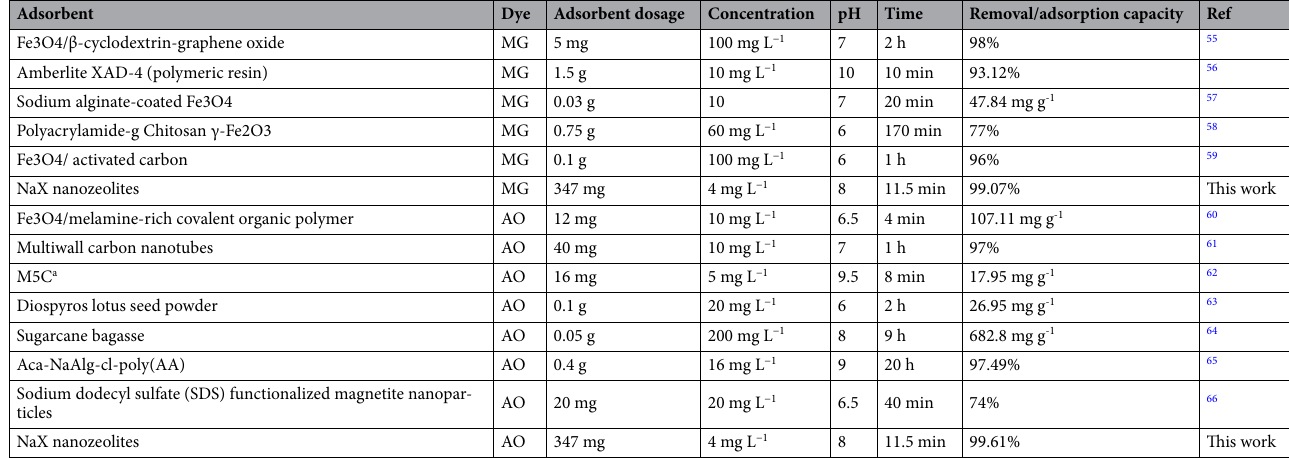
Table 7. Comparison of the NaX nanozeolites with other adsorbents for removal MG and AO. a Metal